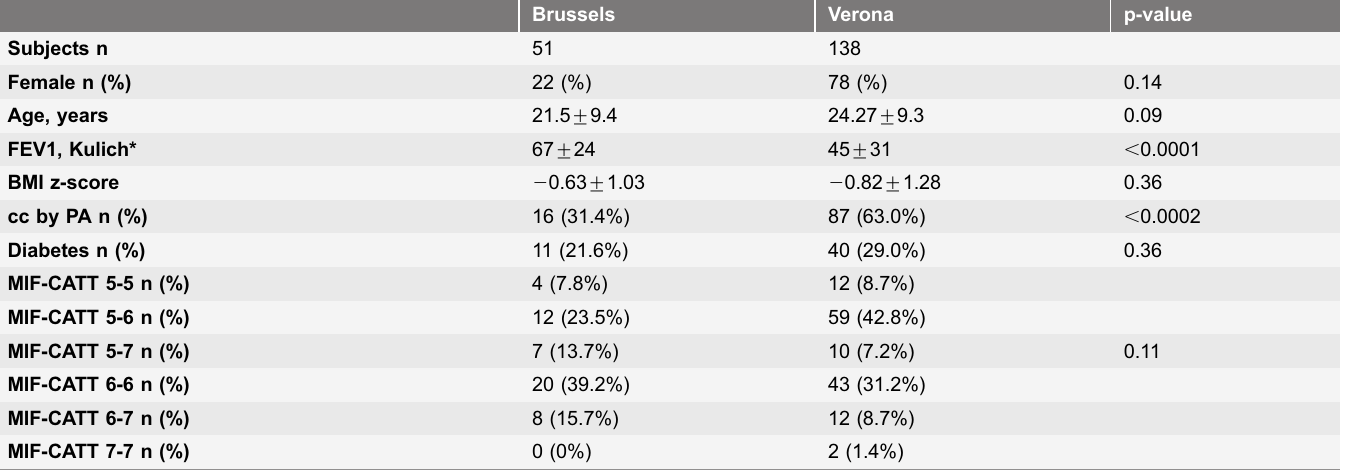
Table 1. Characteristics of 189 Cystic Fibrosis patients homozygous for the F508del mutation recruited from 2 different European